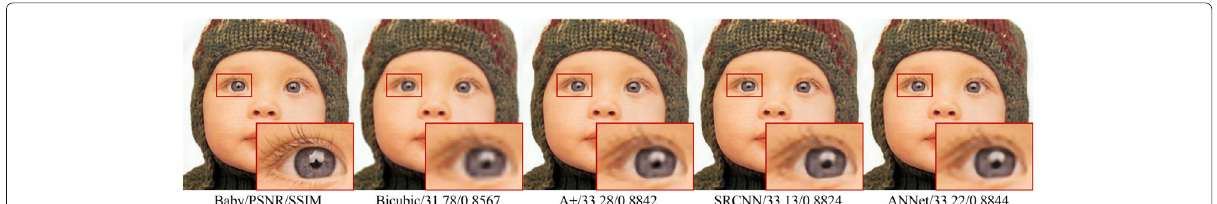
Fig. 5 Visual quality comparison of single image SR on image baby from Set5 [1] with upscaling factor